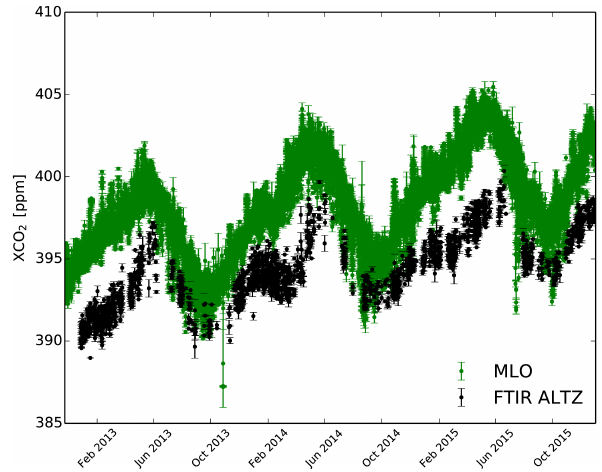
Figure 5. Cumulative function of X CO splitters, with the blue and red dashed lines denoting the precision values from Table 5 obtained from the Sect. 3.2 approach. The black lines depict the existing precision goals for CO 2 found in the litera- ture.